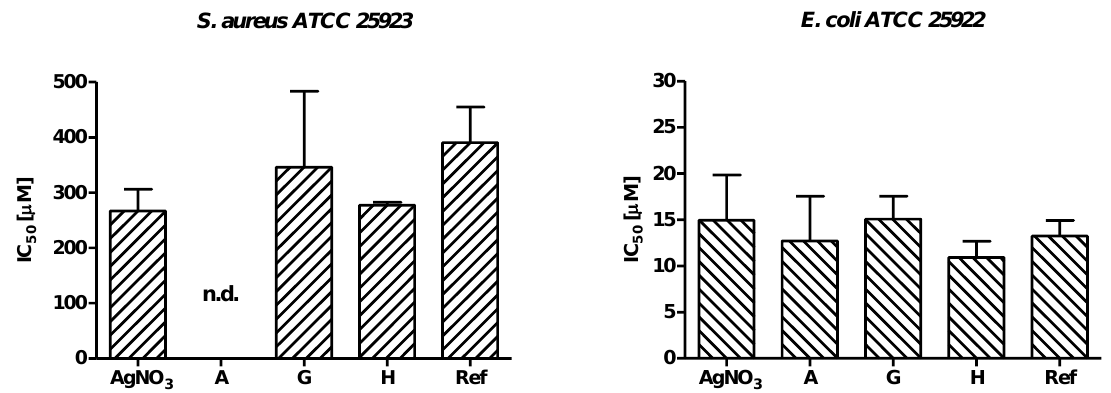
Figure 6. IC 50 values (mean with standard deviation) obtained for the tested samples. The IC 50 value for sample A was not determined (n.d.) on S. aureus as a consequence of the low starting concentration of the sample (300 µM) combined with the poor antibacterial activity of the Ag-based compounds on this Gram-positive strain. No statistical differences were observed when comparing the tested samples (see Table S1).